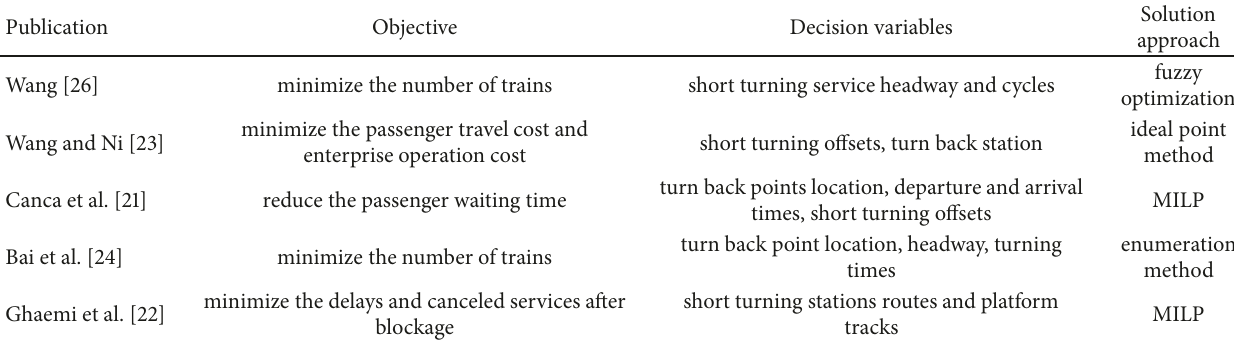
Table 1: Summary of the relevant studies with short turning train scheduling.